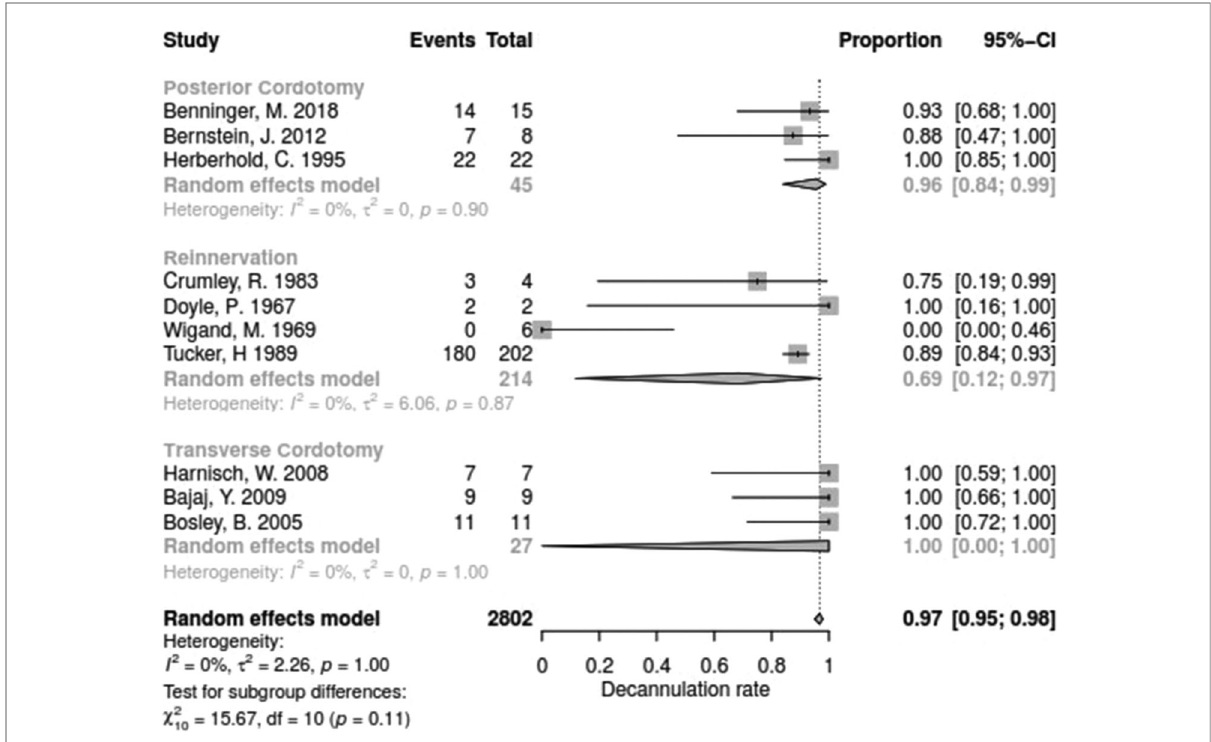
FIGURE 7 Forest plot of decannulation rates in studies on cordotomy or on reinnervation